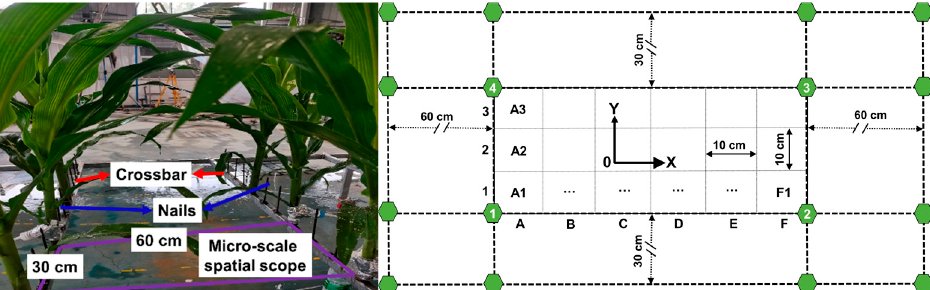
Figure 3. The arrangement of maize plants ( the left ) and measure points ( the right ). Capital letters in the figure represent the spatial distribution of different measurement points between maize rows, and the regular hexagons that are green-filled represent the spatial distribution of maize plants. The regular hexagons filled with green and Arabic numerals represent maize plants and the maize constitute a micro-scale area in the maize field.